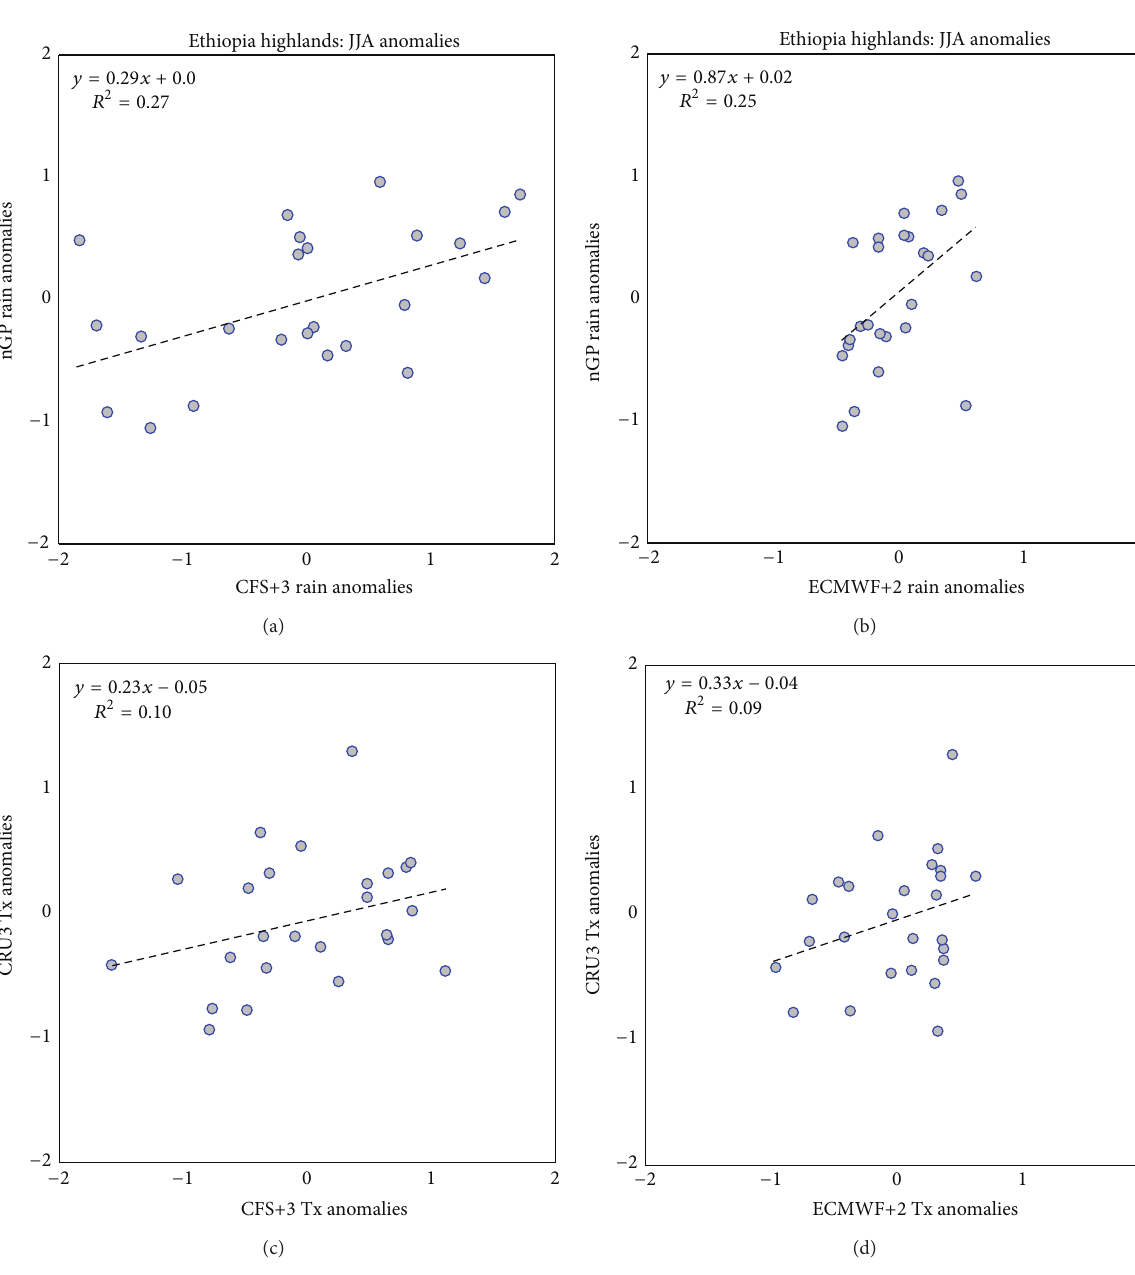
Figure 5: Scatterplots of highlands area-averaged model forecasts compared with JJA observations: (a) March CFS rain, (b) April ECMWF rain, (c) March CFS maximum temperature, and (d) April ECMWF maximum temperature. While rainfall forecasts are significant, temperature forecasts fall